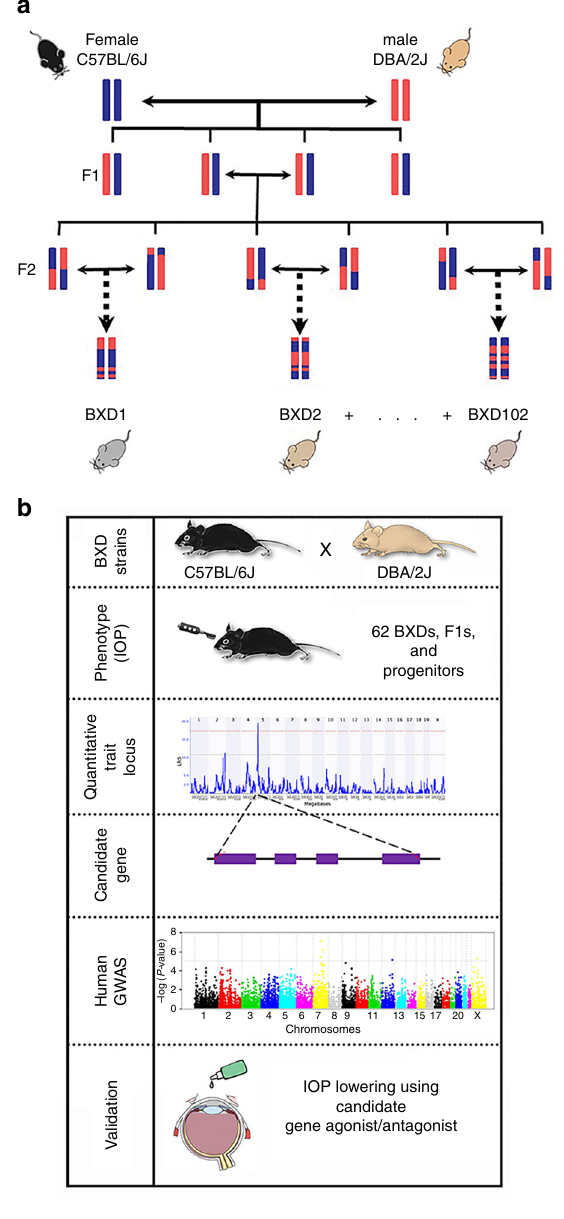
Fig. 1 Overview of IOP systems genetics analyses. a BXD strains derived by crossing C57BL/6J (B6) and DBA/2J (D2) parents. The